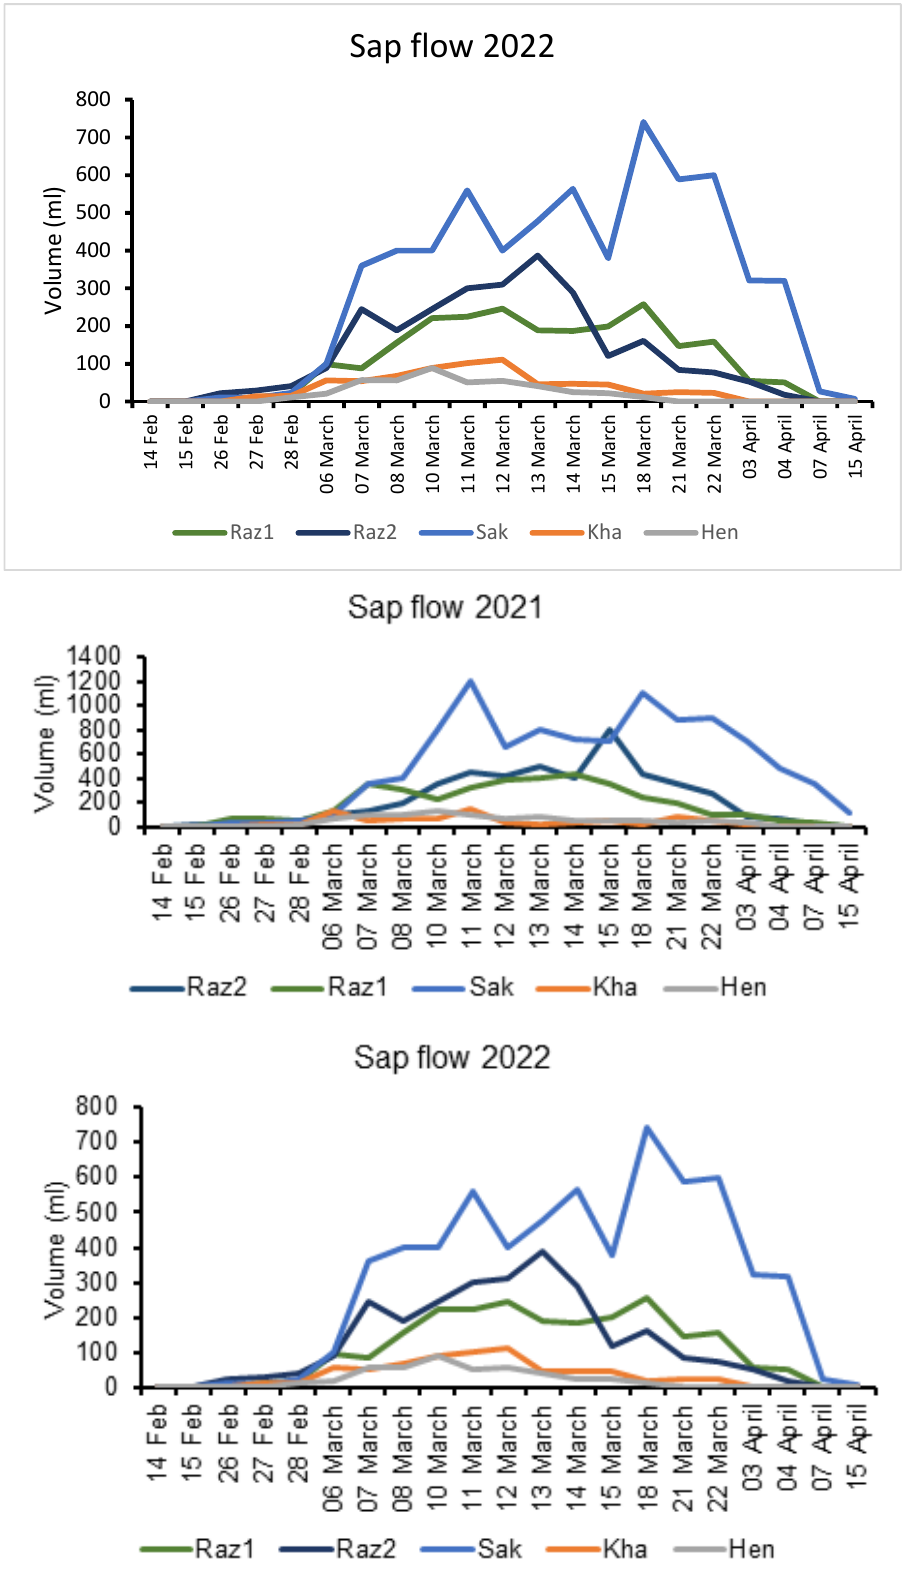
Figure 1. Xylem Sap flow in five Tunisian grapevine cultivars during the bleeding period of 2019, 2021 and 2022. Abbreviations: Sak Sakasly, Hen Hencha, Kha: Khamri, RazI: Razegui1, Raz2: Razegui2.